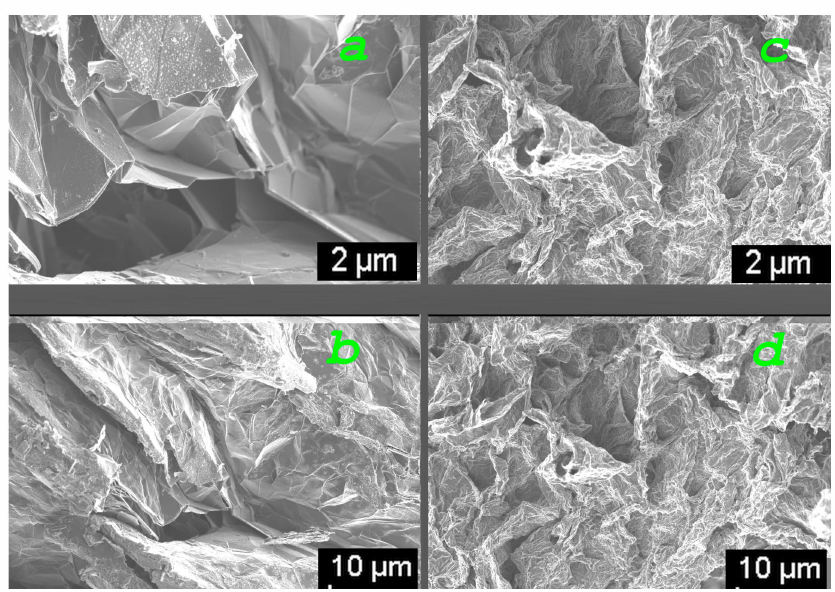
Figure 3. Field-emission scanning electron microscopy (FESEM) images of pristine graphene ( a , b ) and black TiO 2 /Ag/N@rGO with numerous surface defects, irregular structures, and pores ( c , d ).